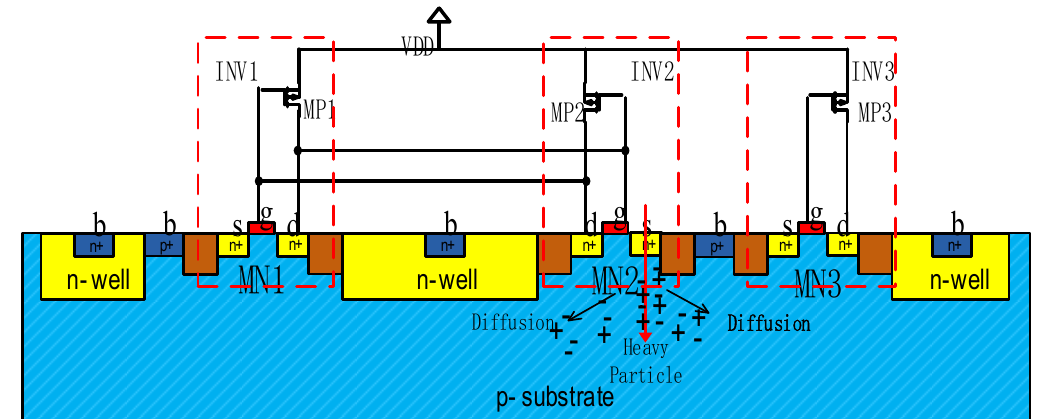
Figure 12. A particle strikes the drain region of MN2 transistor perpendicularly. Cross-sections of layout in a cell of SRAM.